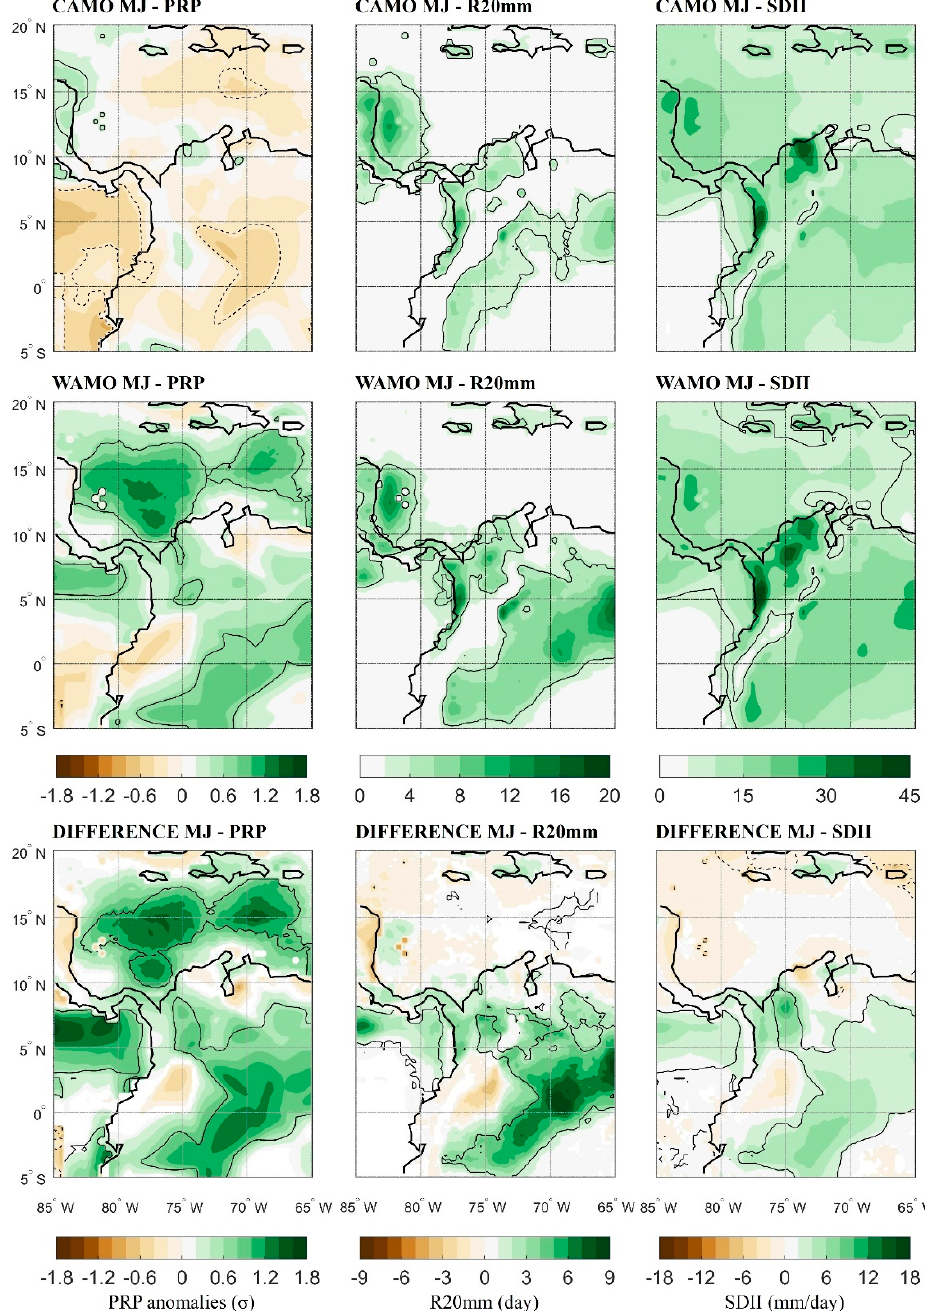
Figure 7. MJ standardized anomaly patterns associated with extreme flow events at Bellavista during CAMO (upper line), WAMO (middle line), and the di ff erence WAMO minus CAMO (lower line) for the precipitation in the ARB (left column), R20 mm (middle column) and SDII (right column). Contour ranges are of 0.2 standard deviations for the precipitation of two days and one day for the R20 mm and R20 mm di ff erence, and of 5 mm.day − 1 and 2 mm day − 1 for the SDII and the SDII di ff erence, respectively. The continuous (dashed) line refers to the significant positive (negative) values at a 95% confidence level.